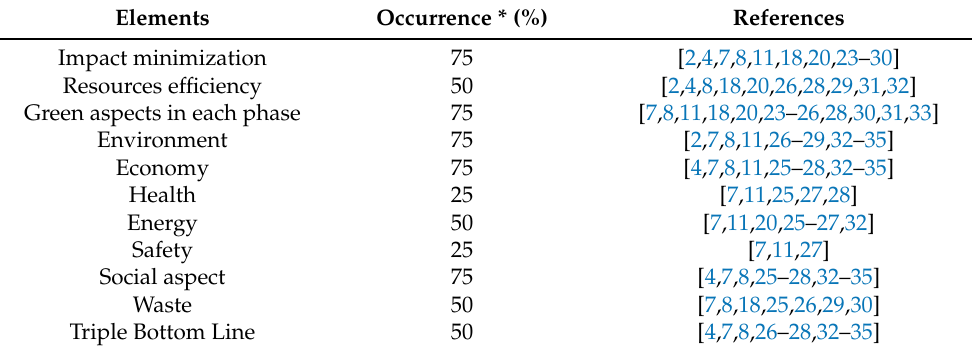
Table 1. Elements for defining sustainability in construction.